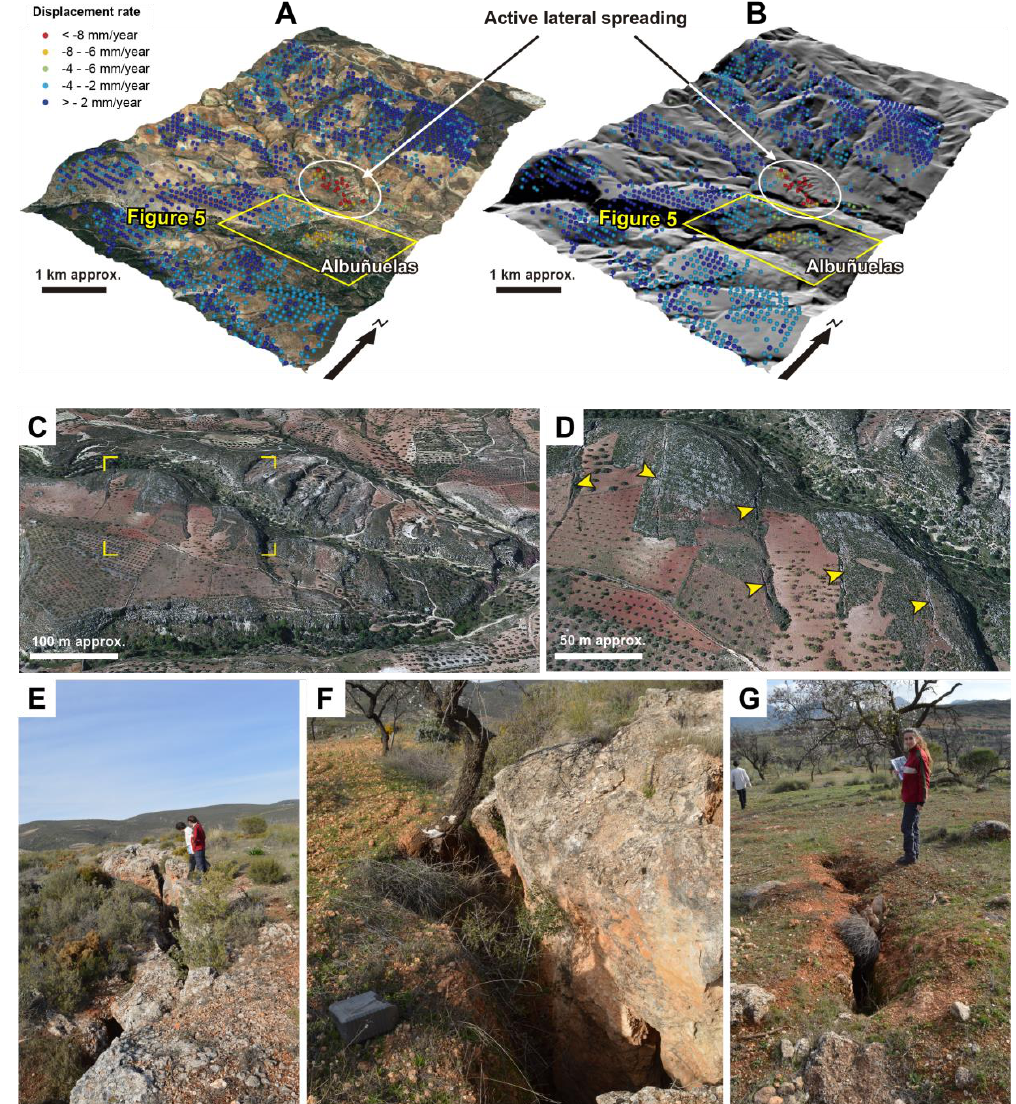
Figure 9. ( A , B ) Three-dimensional (3D) models of the surroundings of Albuñuelas with the surface velocity provided by GEP; ( C ) Oblique northward aerial view of the horst and graben landscape produced by the active lateral spreading phenomenon (from Google Earth, www.google.com/earth); The yellow marks delimit the area represented in ( D ), ( D ) Oblique northward aerial view of the southern sector of the lateral spreading where the open cracks can be distinguish (from Google Earth, www.google.com/earth); ( E – G ) Field photographs of the cracks with vertical steps of about 1.5 m ( E , F ) and an example of the piping phenomena identified in the area covered by surficial deposits ( G ).